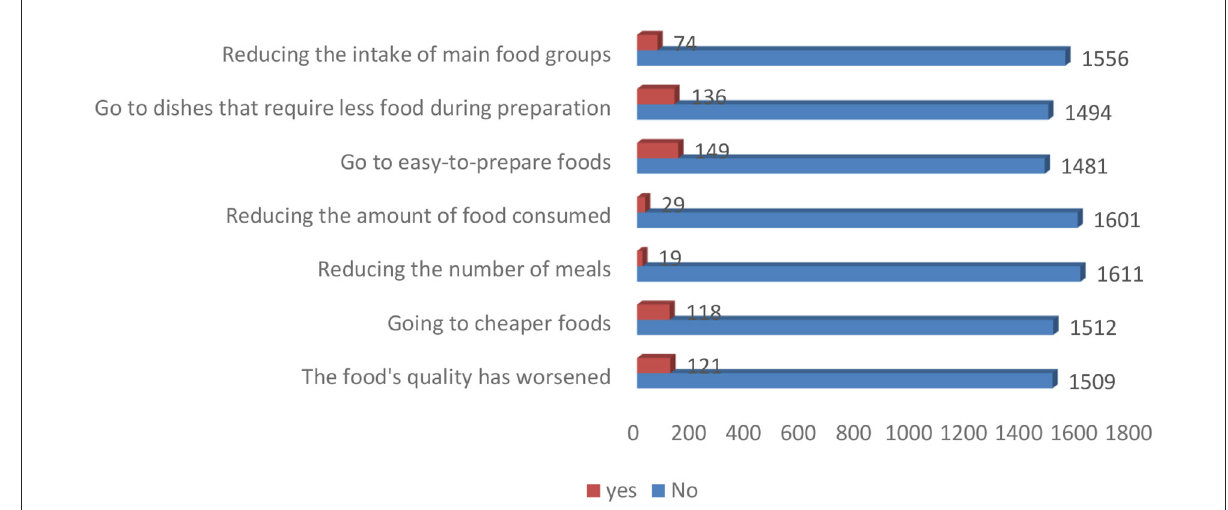
FIGURE1 Mitigation measures adopted by post-partum women to cope with the situation during the